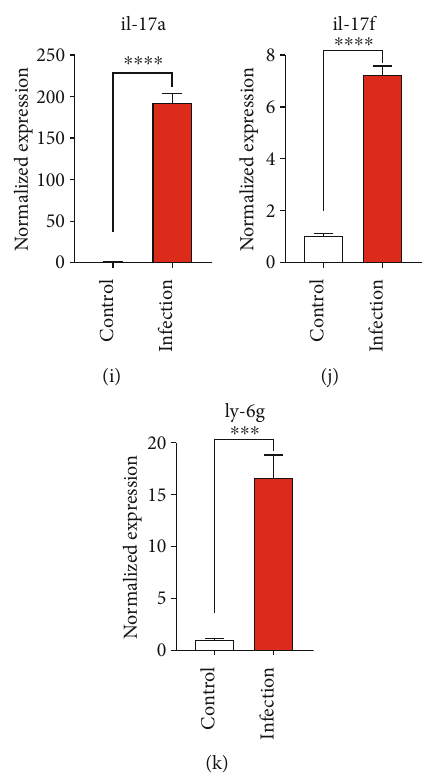
Figure 6: Validation of mRNA expression level of selected signi fi cant chemokines, cytokines, and cell markers. BALB/c mice were intratracheally inoculated with 1x10 6 CFUs K. pneumoniae YBQ for 48 hours or not. Chemokines ccl2 (a), ccl3 (b), ccl4 (c), cxcl2 (d), cxcl3 (e); cytokines il-1b (f), il-6 (g), tnfa (h), il-17a (i), il-17f (j); neutrophil marker ly-6g (k). Unpaired t -test was performed to calculate the signi fi cance of di ff erence between infected lungs and normal lungs ( n = 3 ). ∗∗ , P < 0 : 01 ; ∗∗∗ , P < 0 : 001 ; ∗∗∗∗ , P < 0 : 0001